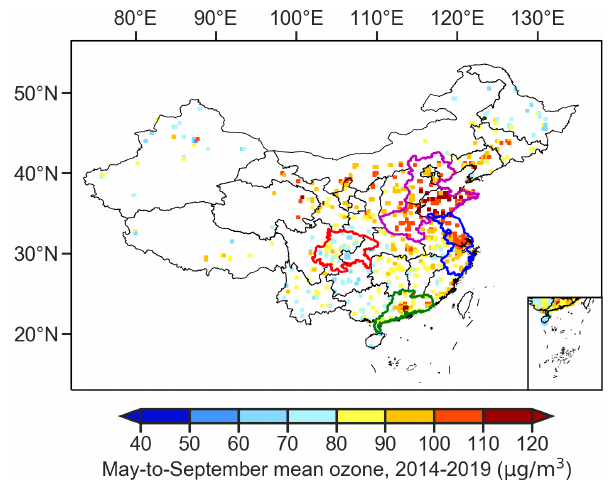
Figure 1. The May-to-September mean hourly surface ozone net- work data from 2014 to 2019. Mean hourly surface ozone con- centrations are calculated on the 0 . 25 ◦ × 0 . 25 ◦ grid. Purple, blue, green, and red outlines indicate the boundaries of North China Plain (NCP), Yangtze River Delta (YRD), Pearl River Delta (PRD), and Sichuan Basin (SCB),